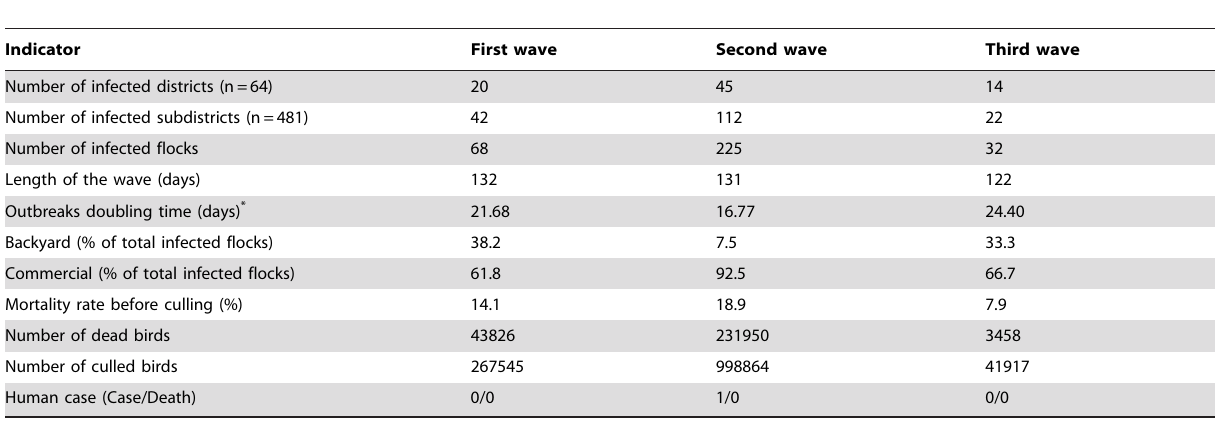
Table 1. Summary of the longevity, magnitude, spatial distribution and mortality of the three different waves of HPAI-H5N1 outbreaks in Bangladesh, 2007–2009.